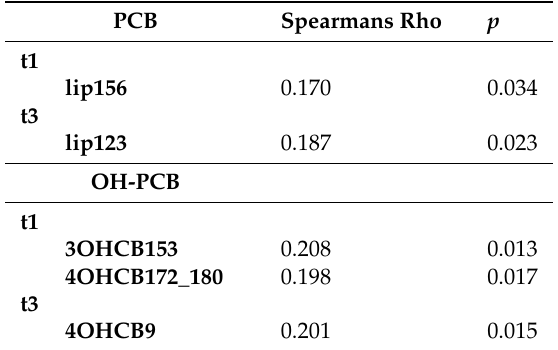
Table 2. Significant Spearman rank correlations between PCB congeners and fT4. PCB Spearmans Rho